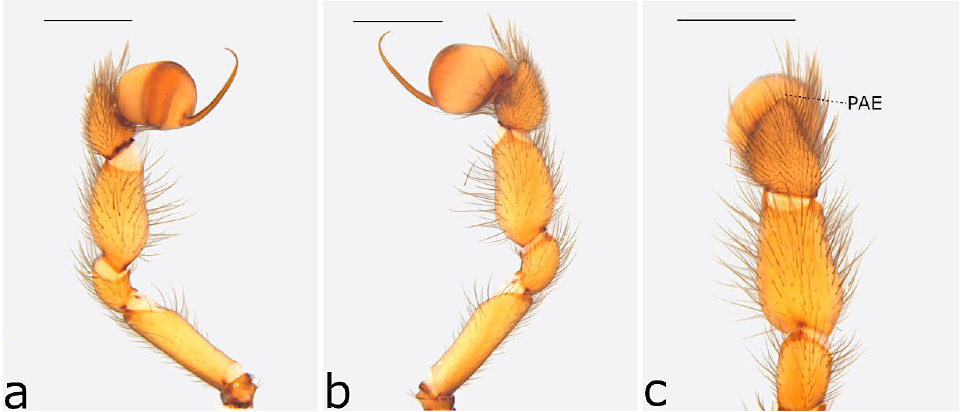
Figure 12. Ariadna otwayensis sp. nov. ♂ holotype (MV K-4985) from the Otway Ranges (Vic): ( a ) left pedipalp, prolateral view; ( b ) same, retrolateral view; ( c ) same, cymbium. Scale bar = 1 mm. Ariadna sinuosa sp. nov.